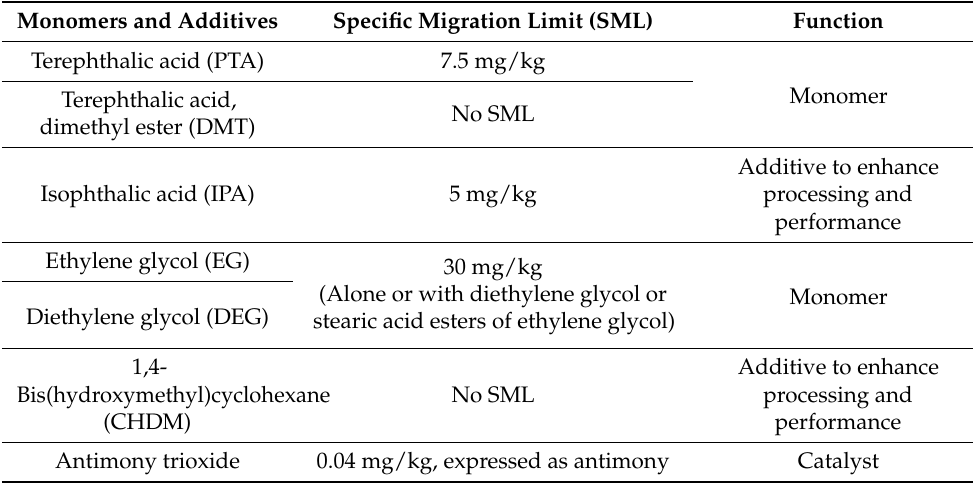
Figure 12. Multilayer film for food packaging applications. Table 5. Monomers and additives used in PET manufacturing for food packaging. Adapted from Table 2 in reference